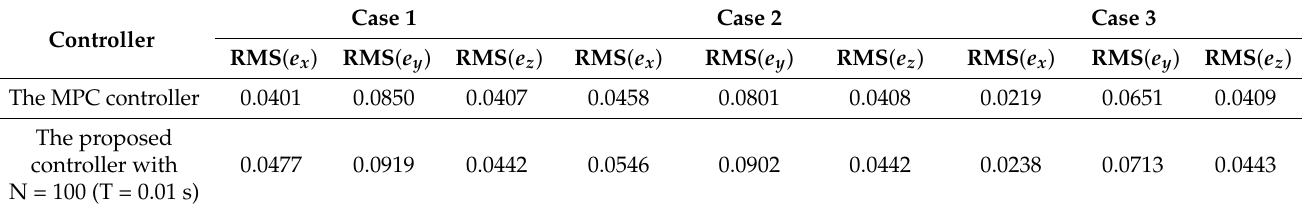
Table 7. The RMS errors (m) by using the MPC controller and the proposed controller under various noise conditions. Controller